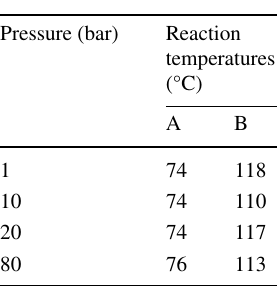
Table 2 Expected decomposition temperatures of LiAB calculated